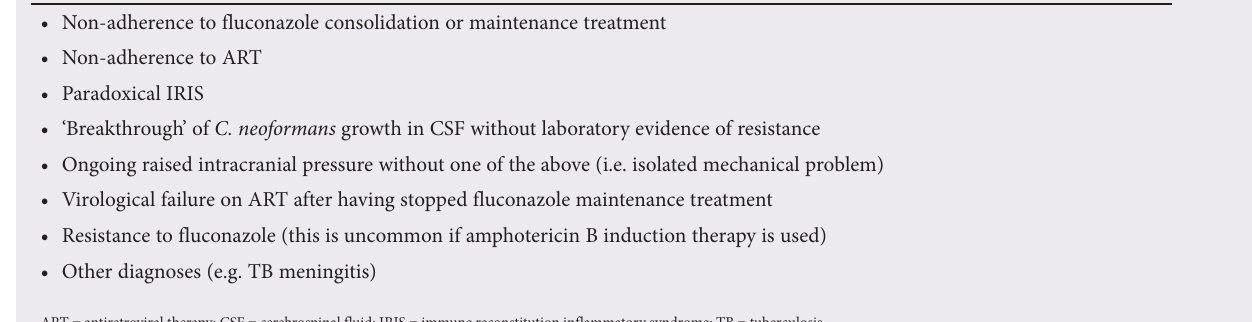
Table 7. Possible causes of recurrent symptoms and signs of meningitis in